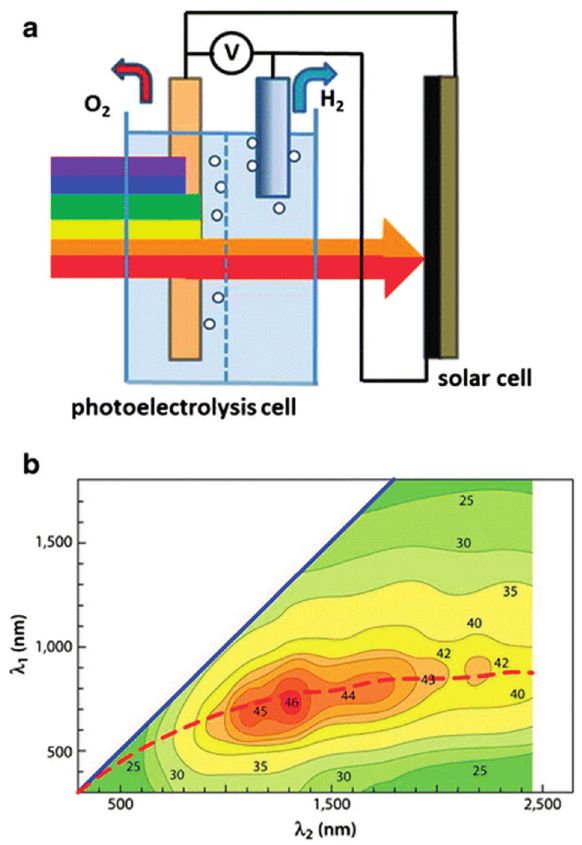
Figure 17. ( a ) Water splitting tandem cell: photoanode passes NIR light to solar cell, giving cathodic bias for H 2 evolution; ( b ) Dual absorber efficiency curve ( η STH > 40% at λ a ≤ 750nm (1.6 eV), λ sc = 750–1300 nm (0.95 eV) (reproduced from [200] with permission from